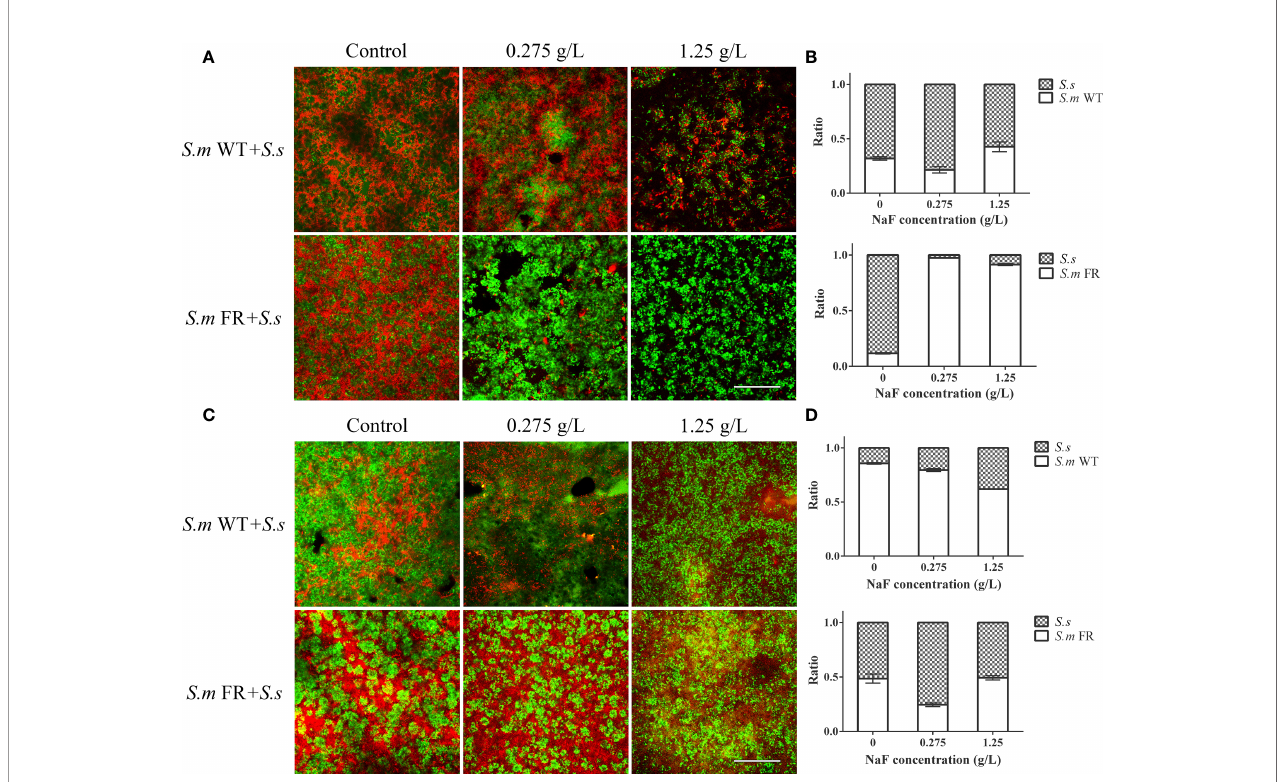
FIGURE 1 | The composition of dual-species bio fi lm was monitored using fl uorescence in situ hybridization (FISH) and qRT-PCR. (A) FISH images of 24-h dual- species bio fi lm in bio fl m formation. (B) Composition of dual-species bio fi lm based on qRT-PCR in bio fl m formation. (C) FISH images of pre-formed bio fl ms. (D) Composition of dual-species pre-fromed bio fi lm based on qRT-PCR. S. m was labeled in green, while S. sanguinis was in red. Size marker equals 60 m